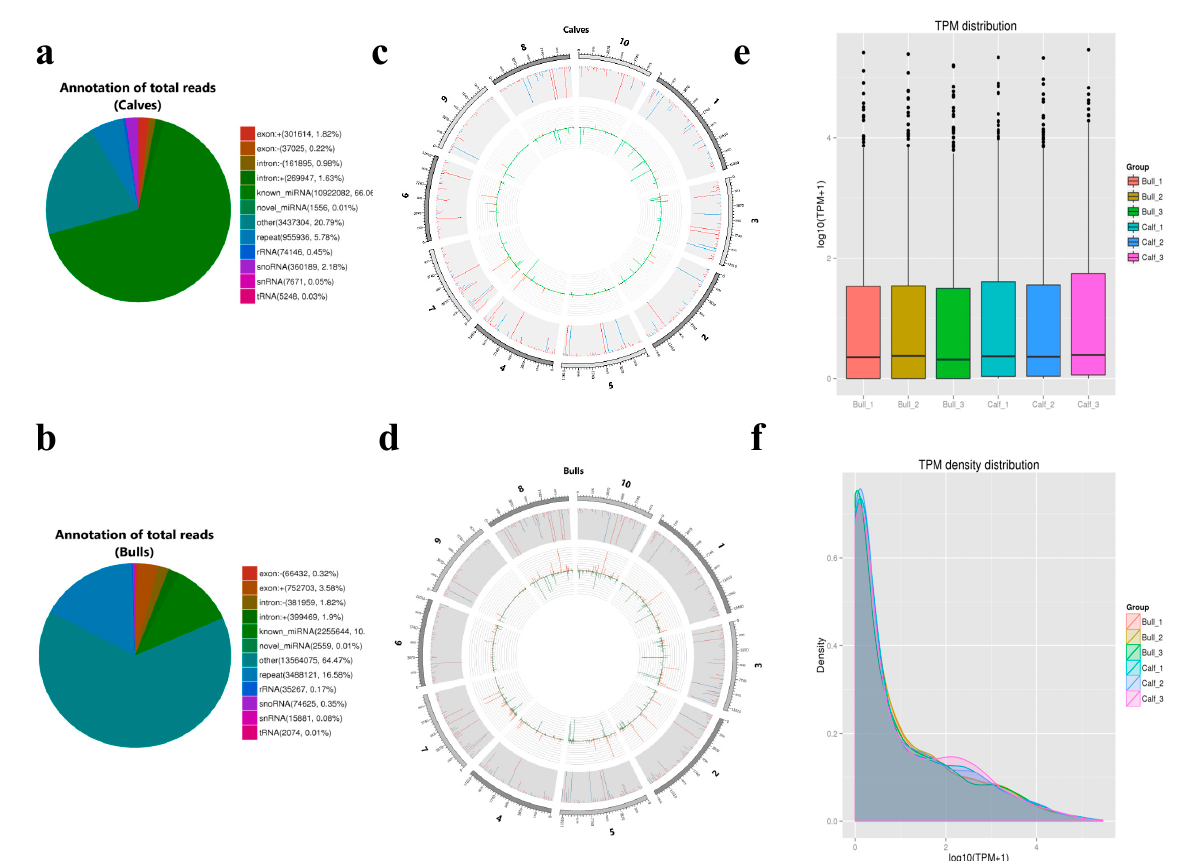
Figure 5. The general features and characteristics of miRNAs in bull and calf testicular tissues were tested. ( a , b ) The schemes represent the different annotated sub-classes of miRNA. ( c , d ) The miRNAs are distributed at chromosomal sets in the bovine genomics. The outer-most ring showed the chromosomes selection. In the middle, the gray background area showed the distribution of reads, whereas red mapping highlighted the positive chain and blue mapping the negative chain. The innermost circle presents the reads comparison among the chromosomes. ( e ) A box graph was used to depict the expression levels of transcripts in various bull and calf samples. ( f ) The X-axis shows the log10 (TPM + 1) value of miRNA, and the ordinate indicates the density of the corresponding log10 (TPM +